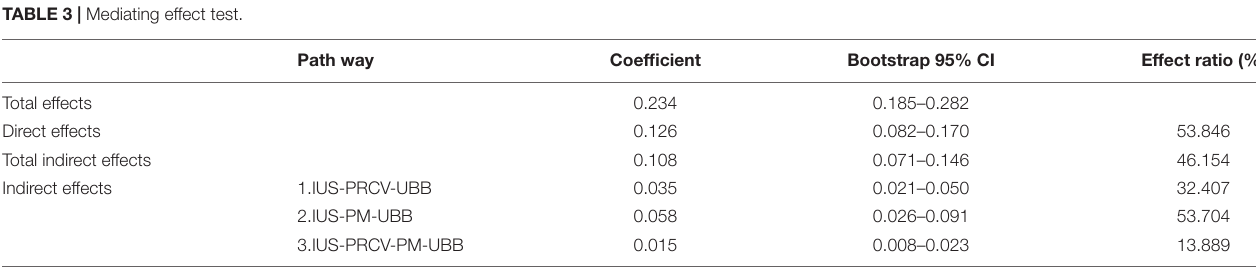
TABLE 3 | Mediating effect